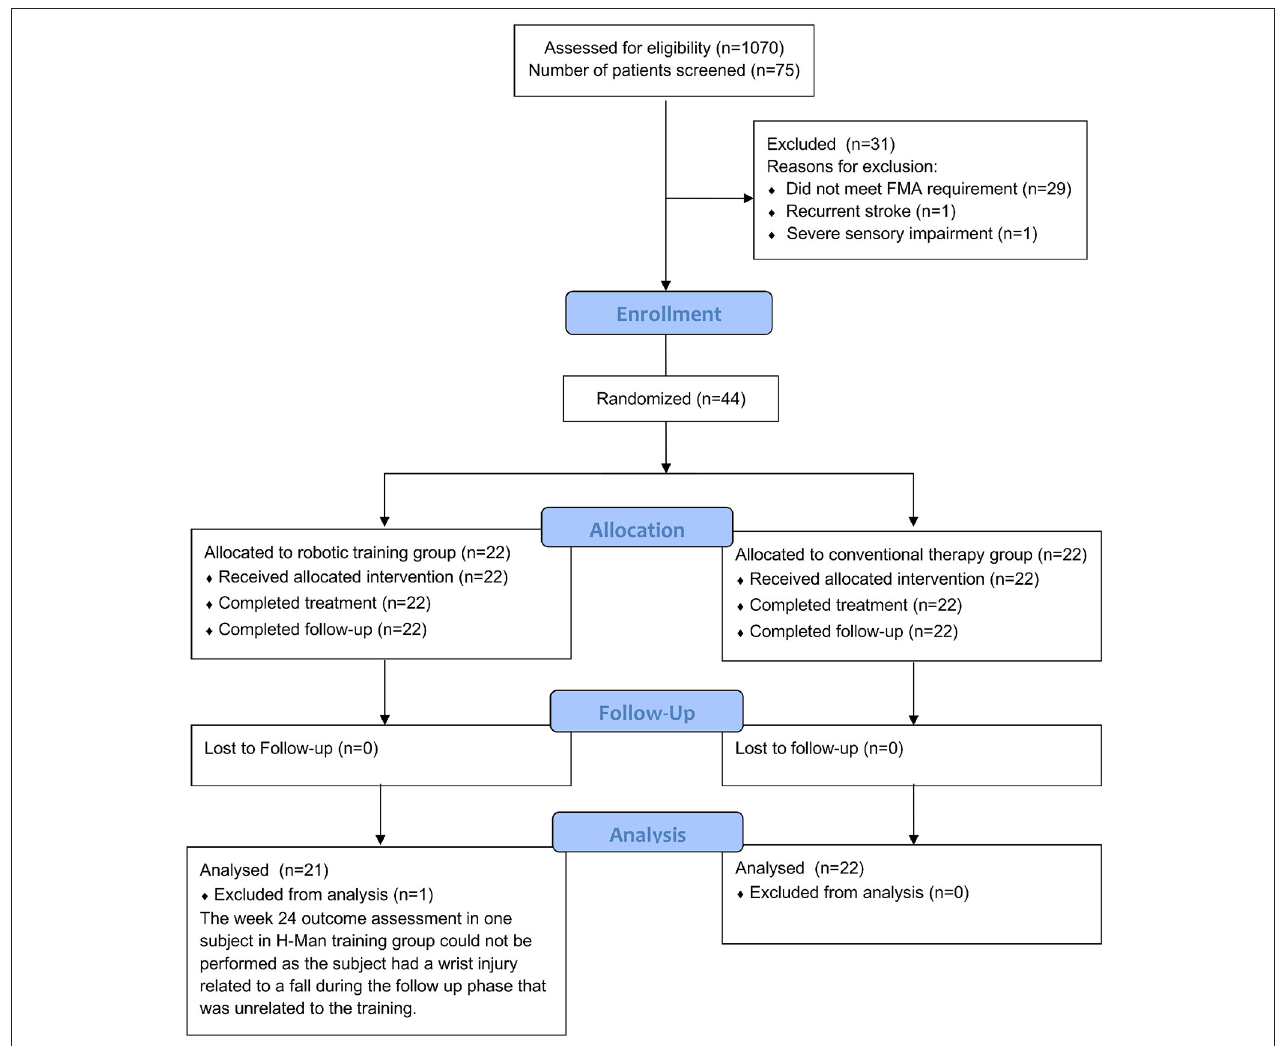
FIGURE 1 | CONSORT